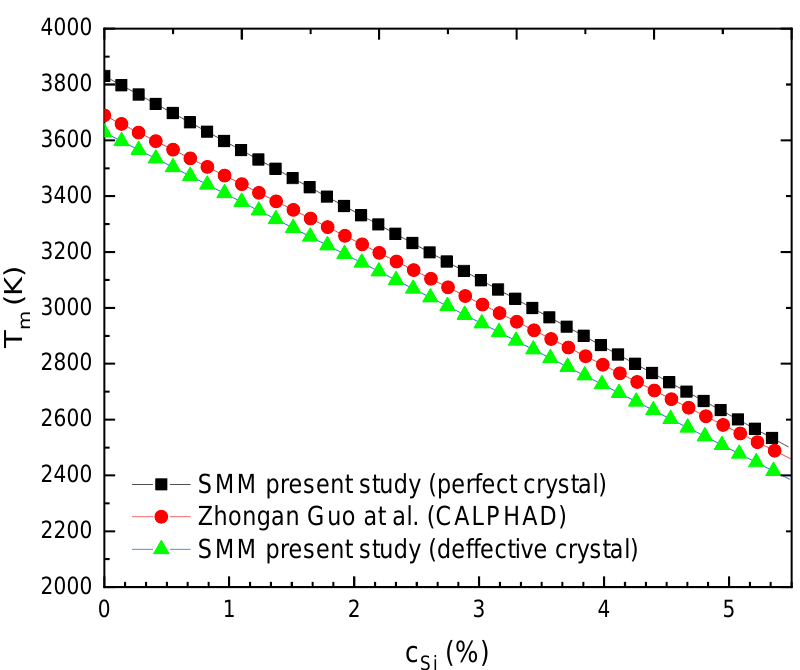
Figure 7. For WSi at P = 0 obtained from the SMM for the perfect model [3], the SMM for the defective model [3] and CALPHAD [40].